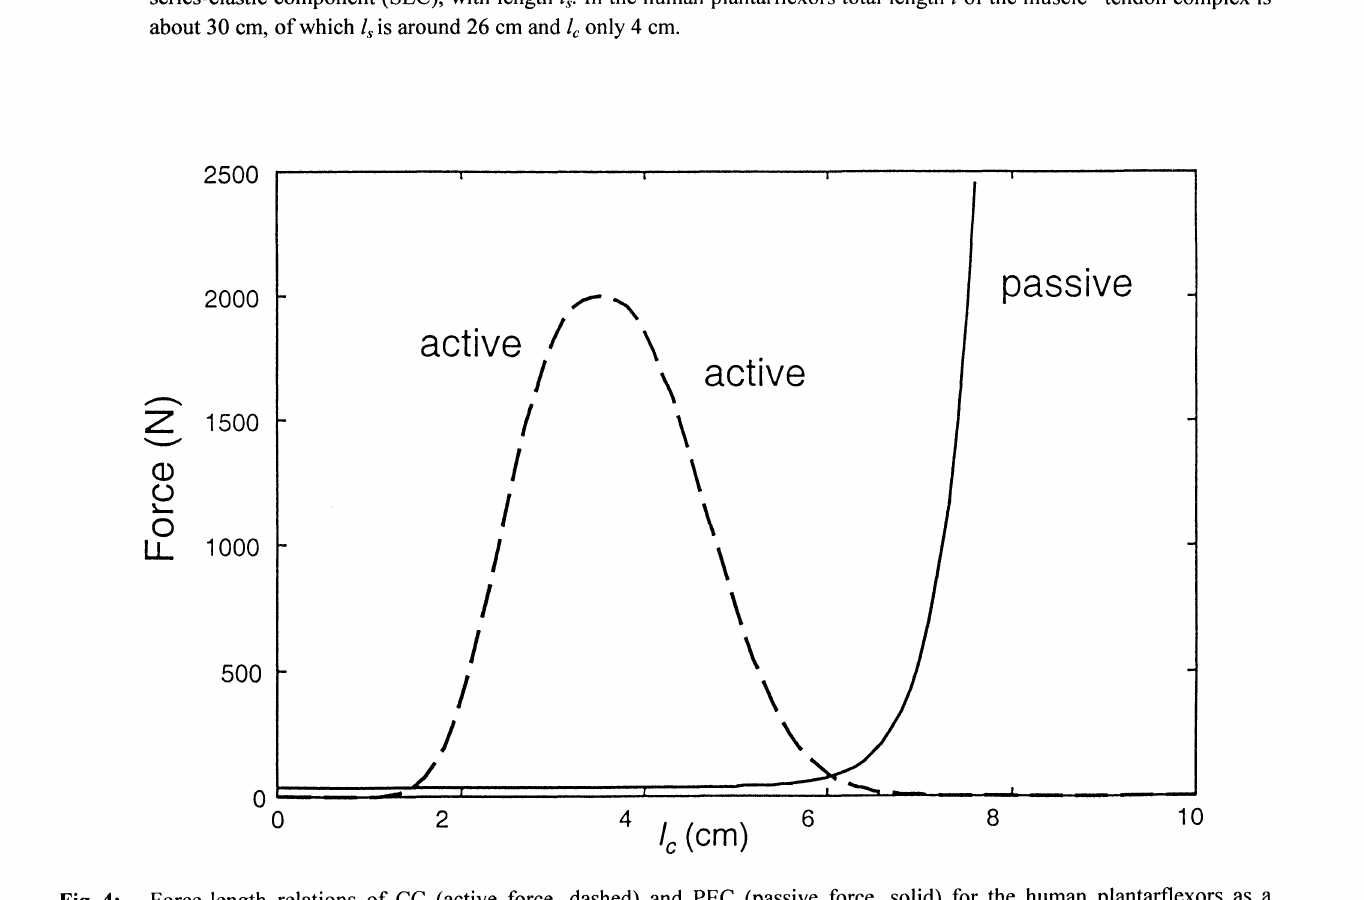
SEC CC F PEC Is (MTC) Fig. 3: Schematic diagram ofthe mechanical components of muscle. The contractile component (CC) with length lc represents the length of the contractile muscle fibers. The muscle fibers and their associated connective tissue also have elastic properties, the parallel elastic component (PEC). In a series with the muscle fibers are the tendon and aponeurosis, represented in the series-elastic component (SEC), with length l.. In the human plantarflexors total length of the muscle -tendon complex is about 30 cm, of which l. is around 26 cm and lc only 4 cm.